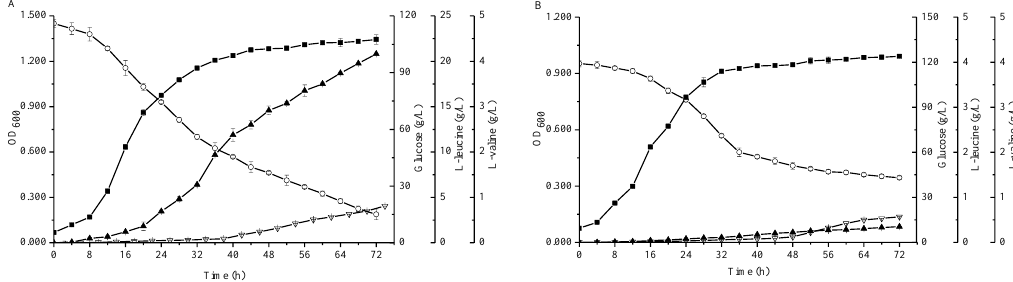
Figure 4. Comparison of the C. glutamicum strains FA-1 △ ilvE /pEC-XK99E- aspB and FA-1 △ ilvE △ aspB during cultivation in shake-flasks with fermentation medium. ( A ) C. glutamicum FA-1 △ ilvE /pEC-XK99E- aspB , ( B ) C. glutamicum FA-1 △ ilvE △ aspB . Solid squares: OD 600 , Hollow circles: Glucose, Solid triangles: L -leucine, Hollow triangles: L -valine. The data represent mean values and standard deviations obtained from three independent cultivations.